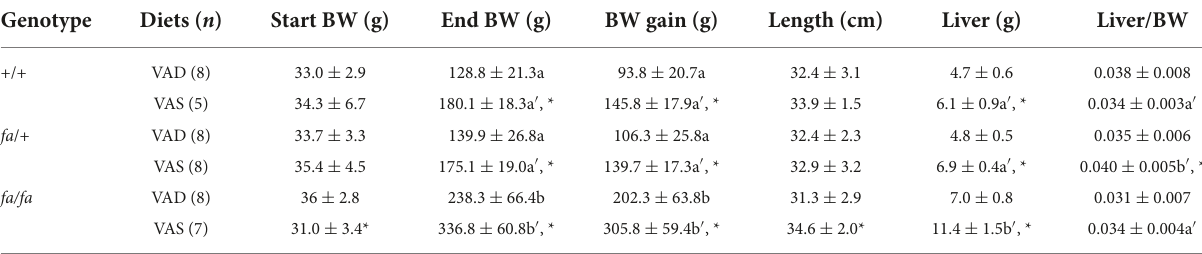
TABLE 2 Body weight (BW), body length, liver weight, liver/BW ratio, and BW gain in female +/+, fa /+, and fa/fa Zucker rats fed a vitamin A deficient (VAD) or vitamin A sufficient (VAS) diet for 8 weeks.